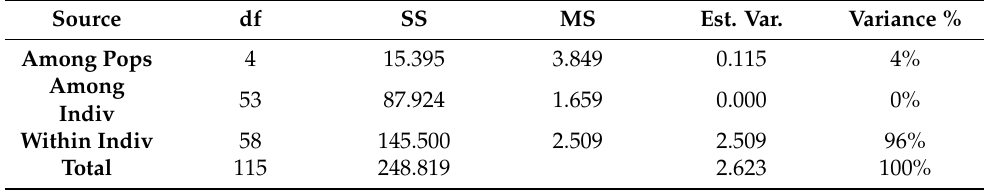
Table 4. The number of the amplified alleles and genetic indices at the studied SSR